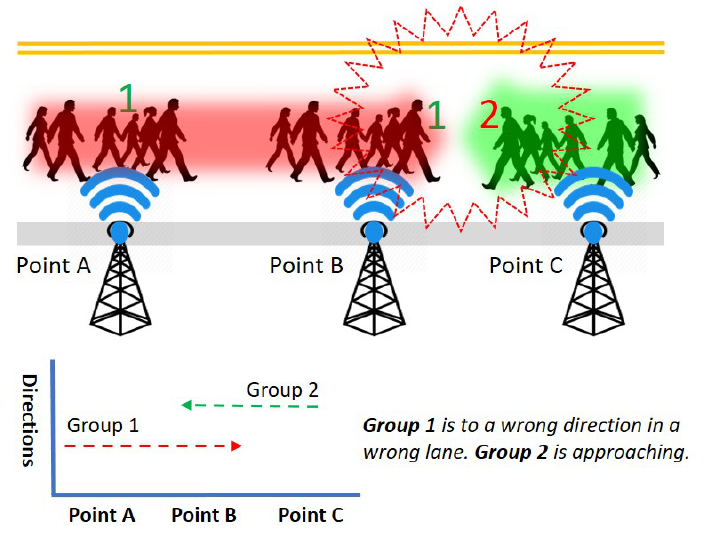
Figure 8. Wrong lane group detection via direction.